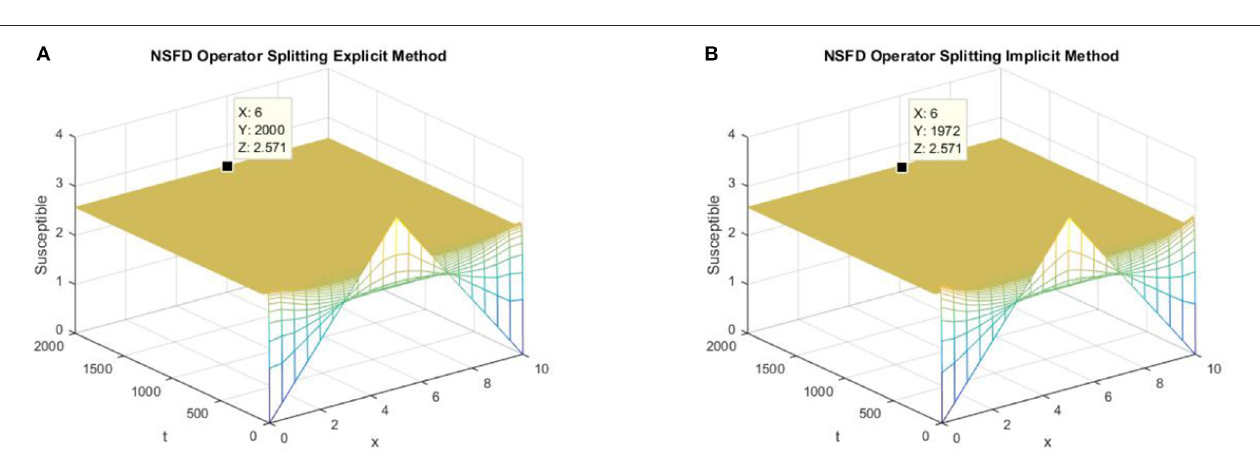
FIGURE 8 | (A) The explicit operator splitting NSFD method is used to simulate the graph of susceptible persons for the DFE point at h = 0.5, λ 1 = 0.4. (B) The implicit operator splitting NSFD method is used to simulate the graph of susceptible persons for the DFE point at h = 0.5, λ 1 = 0.4.